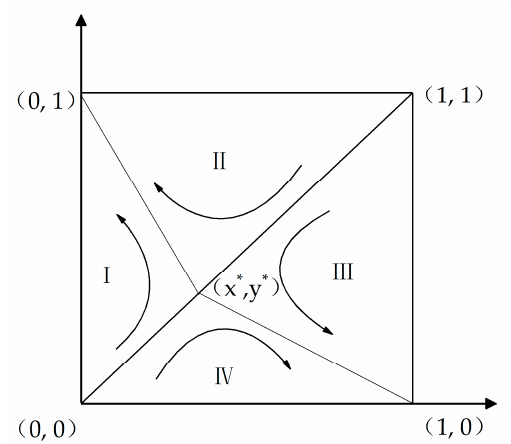
Figure 2. Phase diagram of the evolutionary game in case (4).